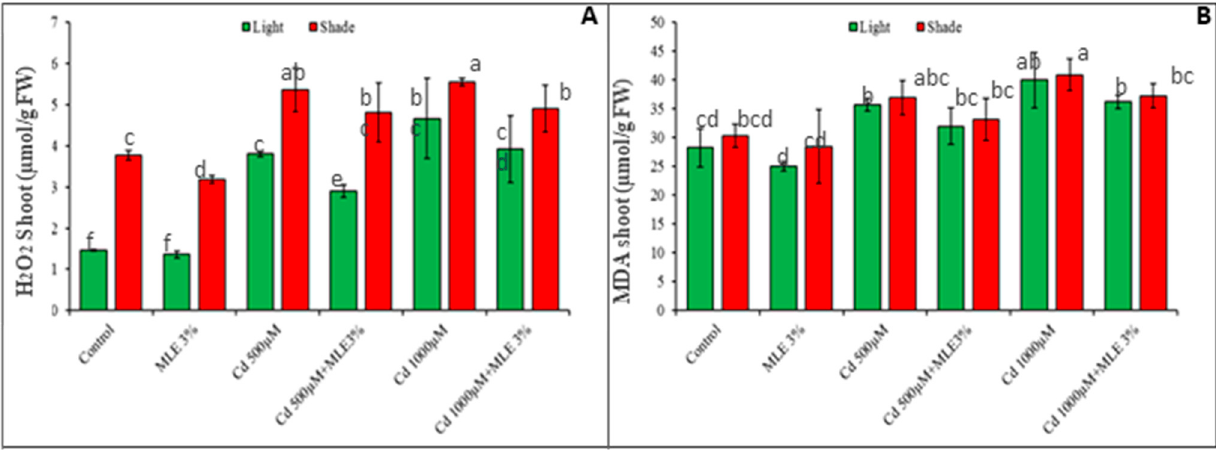
Figure 4. Effect of MLE application on reactive oxygen species ( A ) H 2 O 2 measure of shoot ( B ) MDA measure of shoot, with and without Cd stress under light and subdue light. Different letters above bars represents significant differences ( p < 0.05) at each measured point. Values represent mean ± SE of three replicates of each treatment.